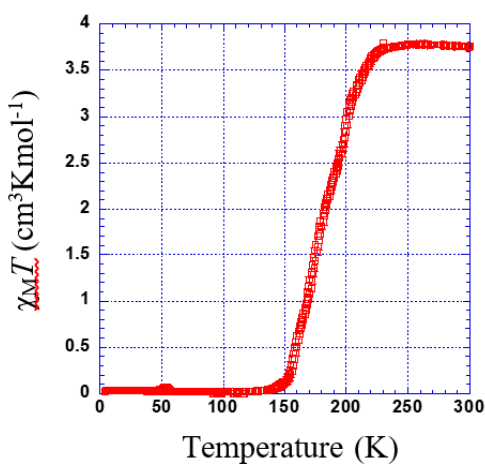
Figure 5. Thermal dependence of χ M T plot for 1 .